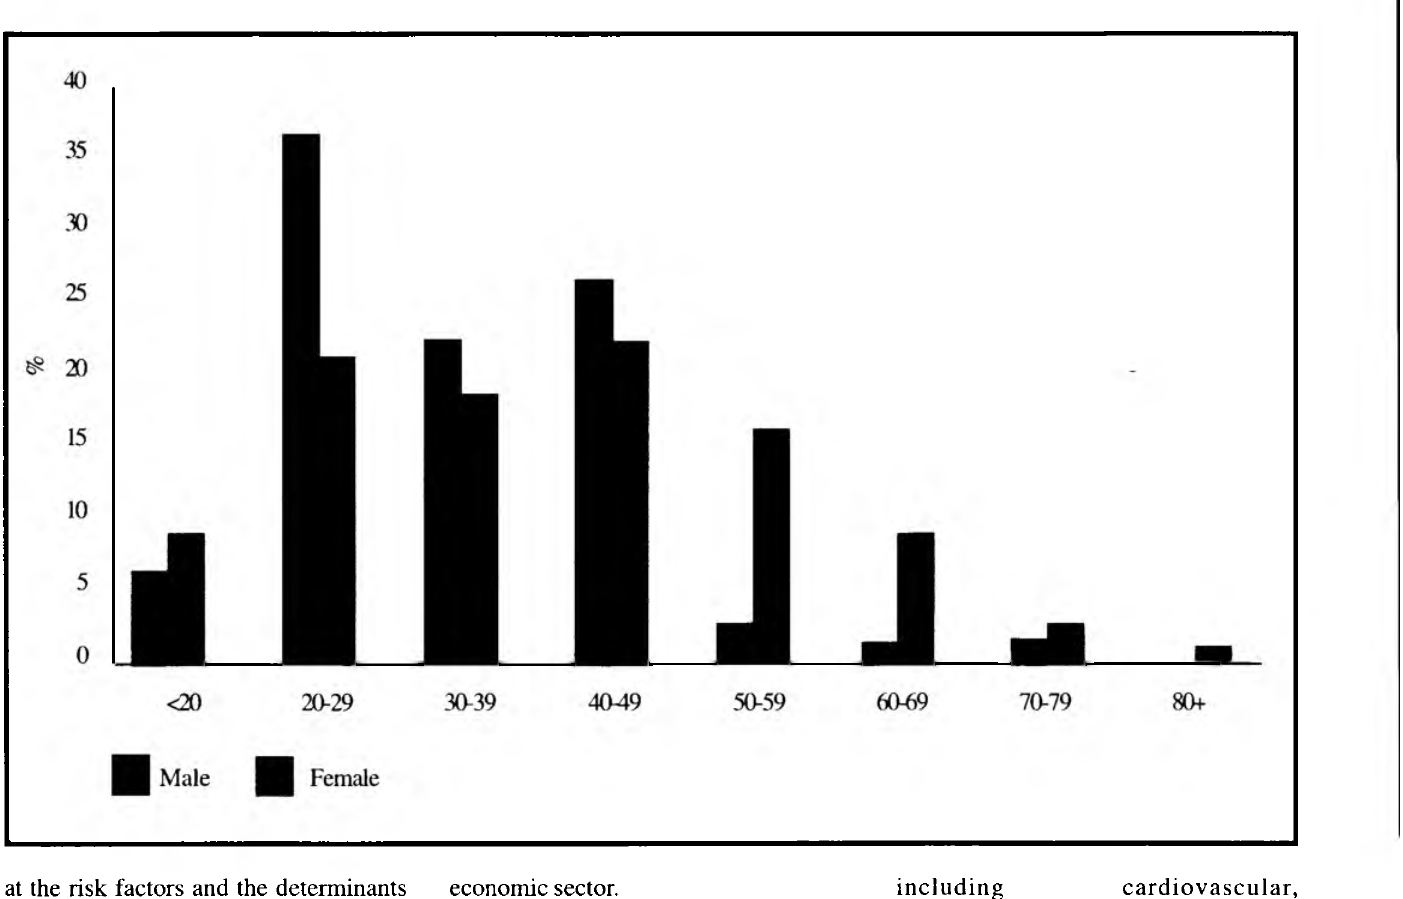
FIGURE 1: Age groups cross tabulated with gender